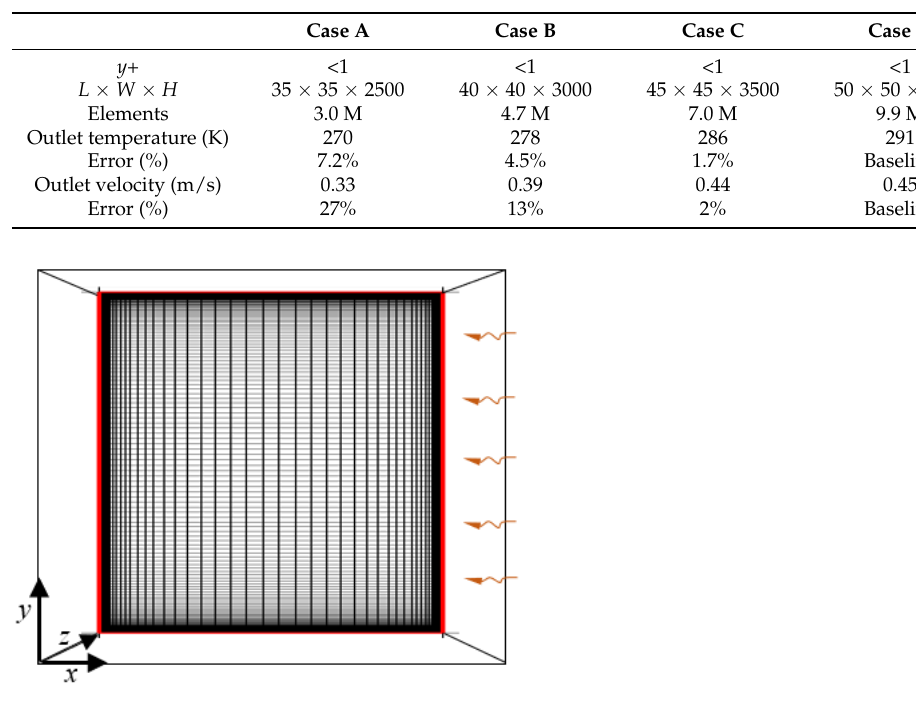
Figure 4. Distribution of the structural